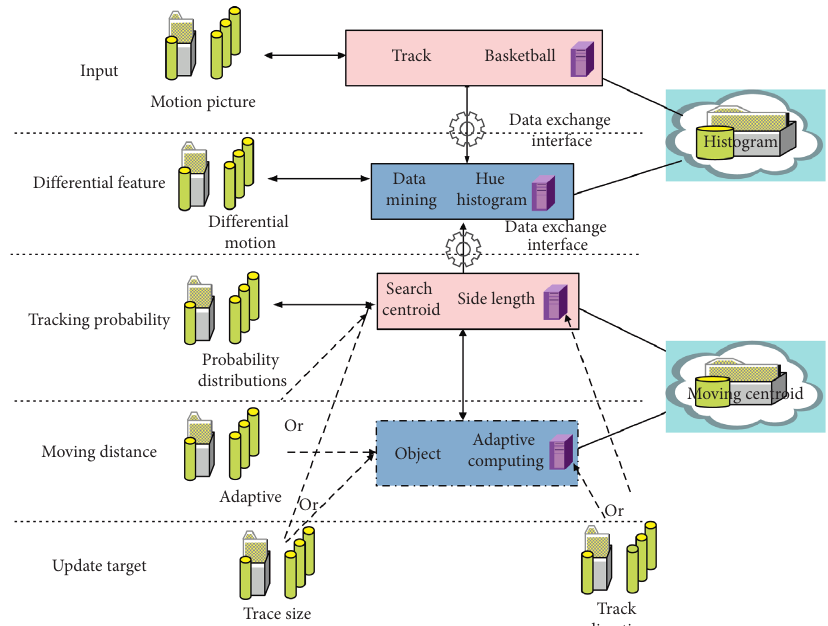
Figure 3: Improved Camshift target tracking algorithm